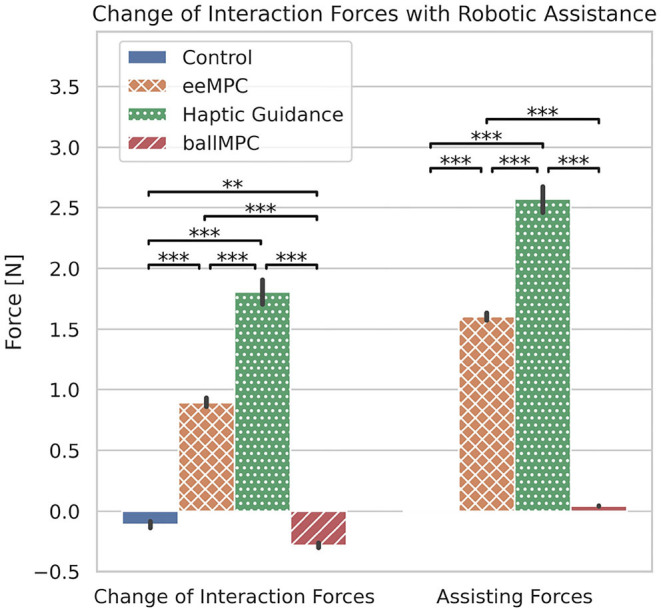
Differences between Assistance ON and OFF in the estimated human-robot interaction forces and applied assisting forces—both in y axis—for each training strategy. The error bars indicate 95% confidence interval. **p < 0.01, ***p < 0.001.